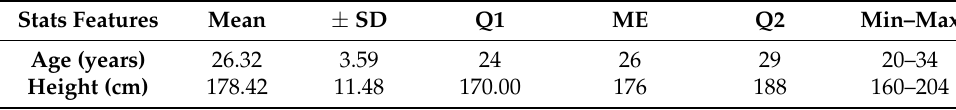
Table 1. Descriptive characteristics of the study participants. Stats Features Mean